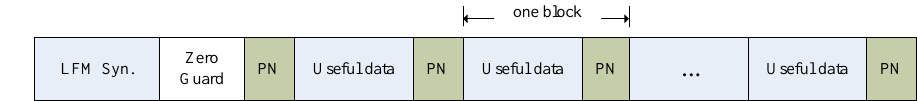
Figure 4. Transmitted signal structure.